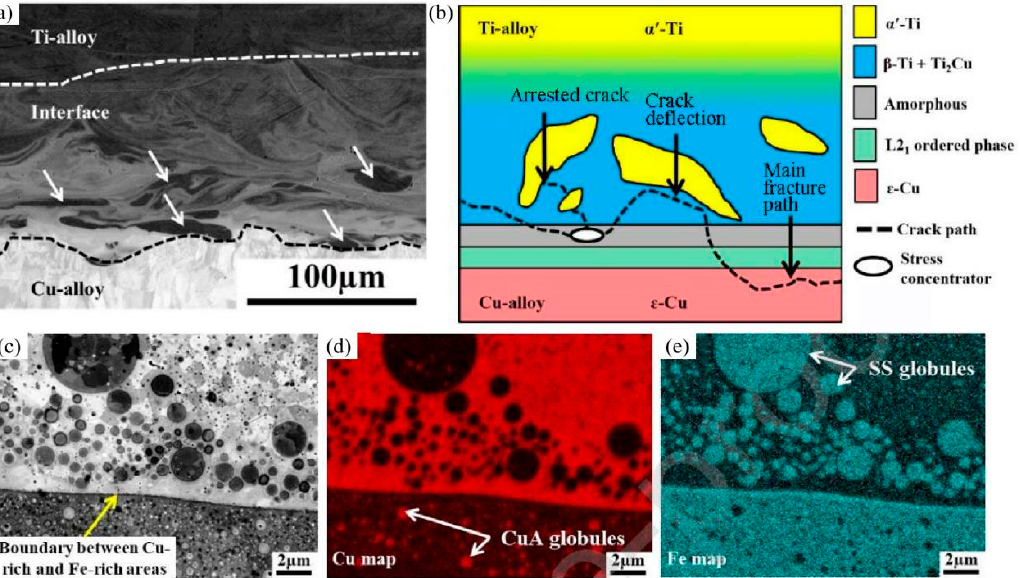
Figure 9. ( a ) Ti–Cu interface, arrows indicate regions of α ’-Ti phase within a matrix of β -Ti + Ti 2 Cu; ( b ) Crack propagation paths under tensile load; ( c ) Fe/Cu interface; ( d , e ) Cu and Fe elemental map [93].